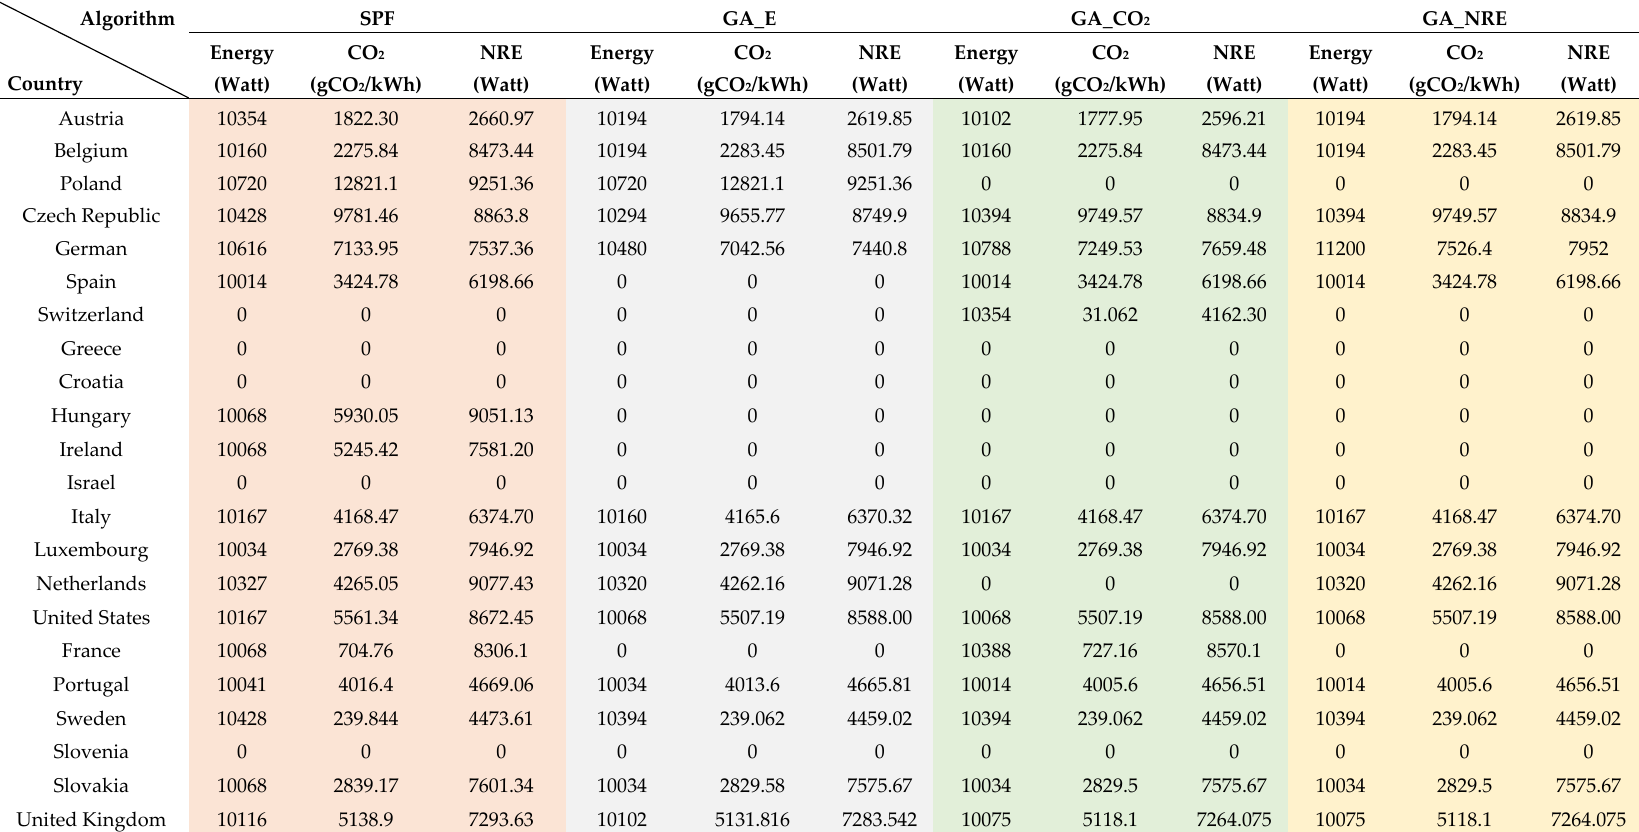
Table A3. Countrywise energy, CO 2 and non-renewable energy consumption values. Table B2. Countrywise energy, CO 2 and non-renewable energy consumption